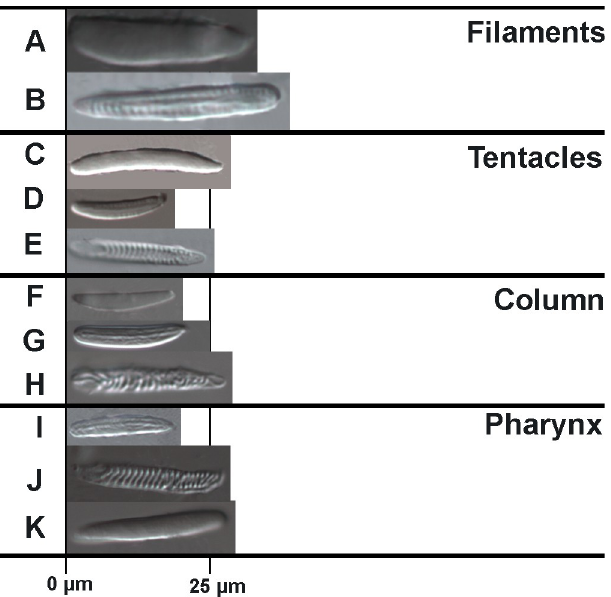
Fig 3. Cnidae of Peachia chilensis . Spirocysts: in tentacles (E), column (H), and actinopharynx (J); basitrichs: in tentacles (D), column (G), actinopharynx (I), and mesenterial filaments (B); holotrichs; in tentacles (C), column (F), actinopharynx (K), and filaments (A). See Table 2 for size and distribution.